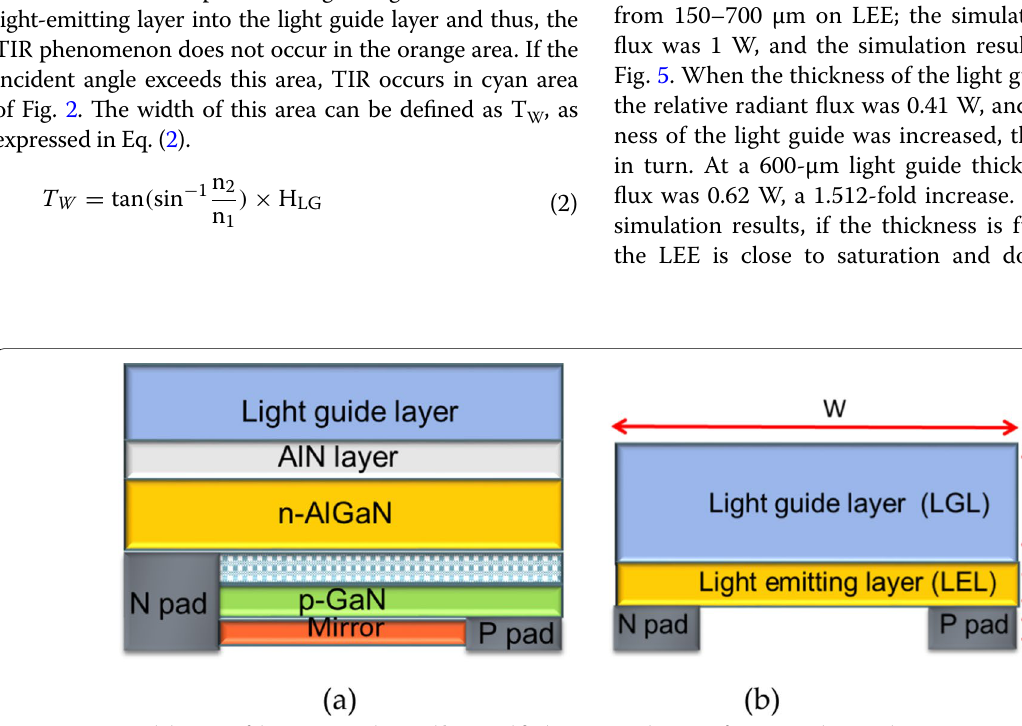
Fig. 3 a Structural diagram of the UV‑C LED chip, and b a simplified parameter diagram of UV‑C LED chip